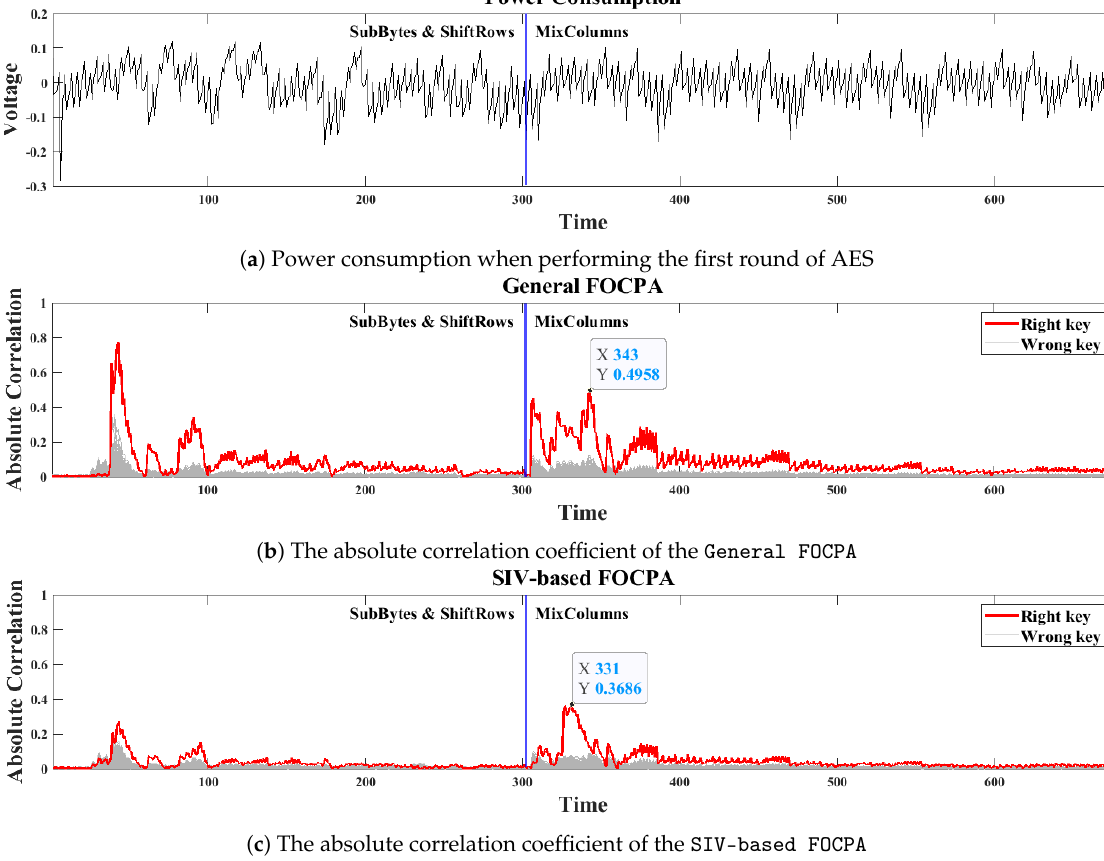
Figure 4. Results of General FOCPA and SIV-based FOCPA . (0th byte).